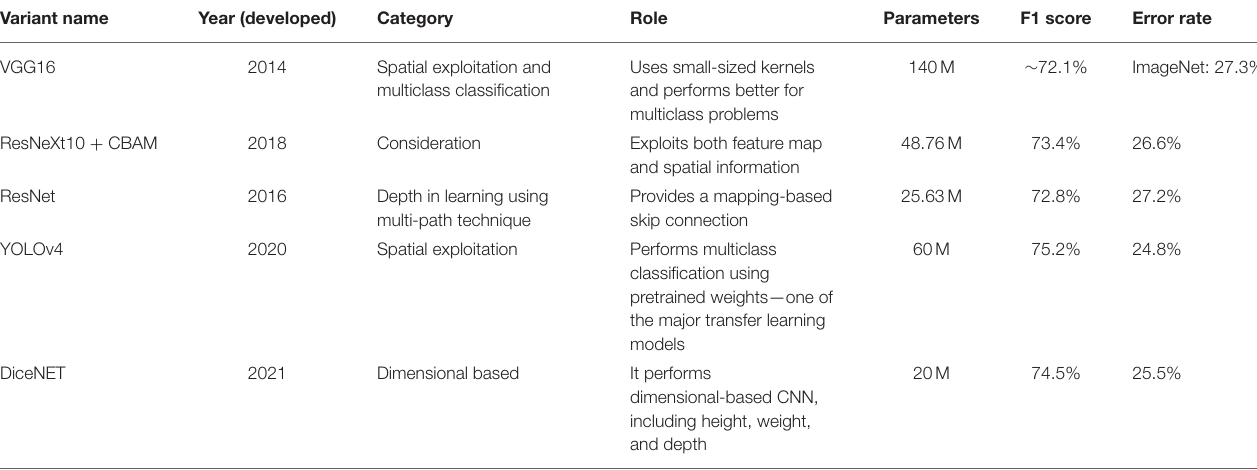
TABLE 6 | Comparing the performance of top CNN models.